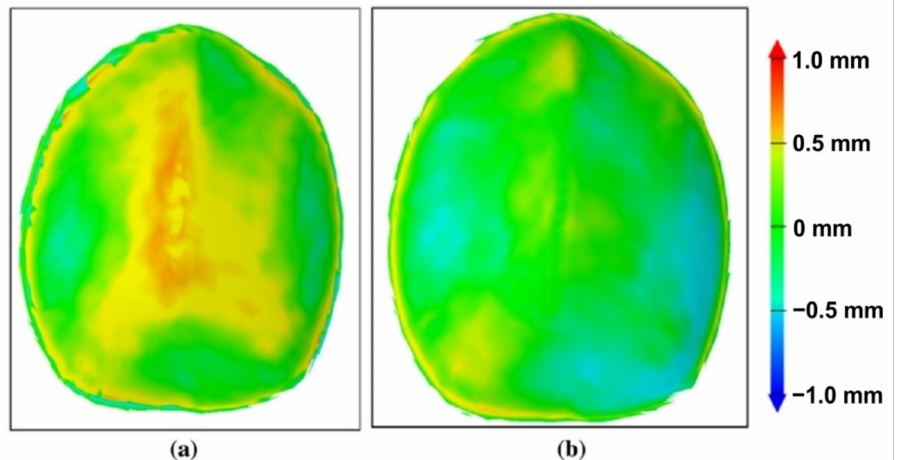
Figure 19. The accuracy plot of a cranial implant manufactured by SPIF with ( a ) an uncompensated toolpath and ( b ) a compensated toolpath (reproduced with permission from [119]; copyright © 2015, Springer-Verlag London; this is an open-access article distributed under the terms of the Creative Commons CC BY license, which permits unrestricted use, distribution and reproduction in any medium, provided the original work is properly